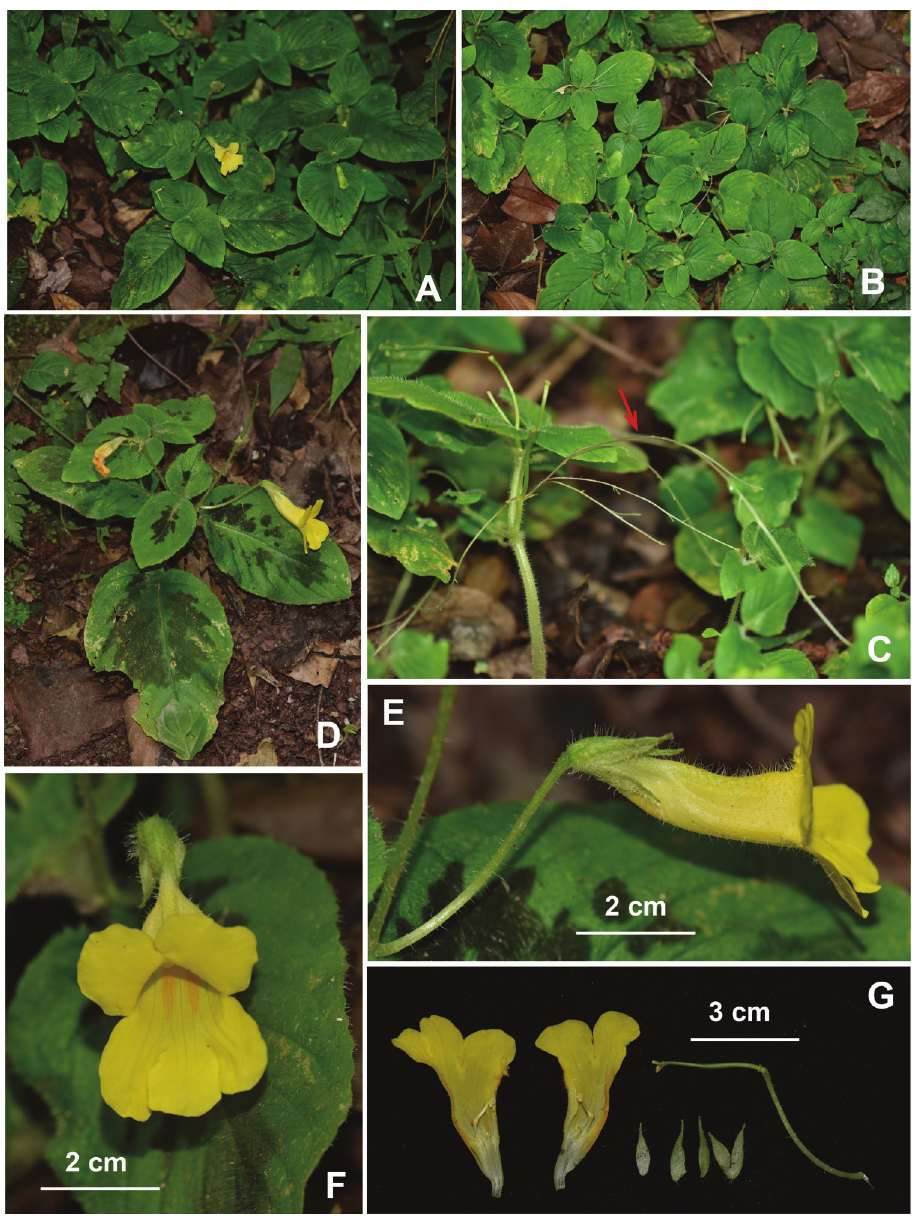
Figure 7. Henckelia xinpingensis Y.H.Tan & Bin Yang, sp. nov. A, B, D Habit C habit (showing stolons) E flower in side view F flower in front view G dissected flower. Photographed by